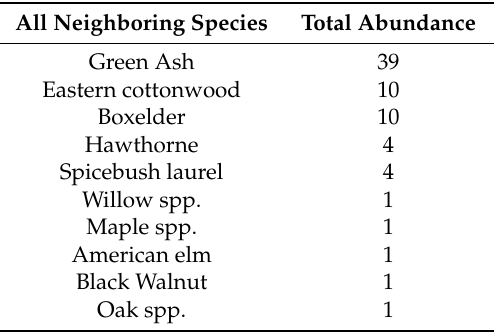
Table 1. The total abundance of each neighboring tree species around our sampled 44 ash trees (6 m radius), in order from most to least numerous. All Neighboring